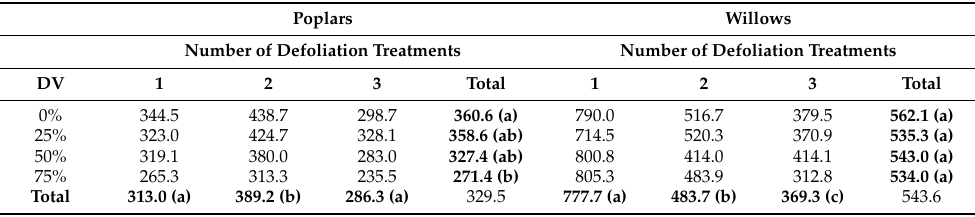
Table 5. Mean fresh weight [g] of aboveground biomass of plants on the study site in Großthiemig with regard to the number of defoliation treatments in February 2009 (DV = defoliation variant, different letters indicate statistically significant differences).